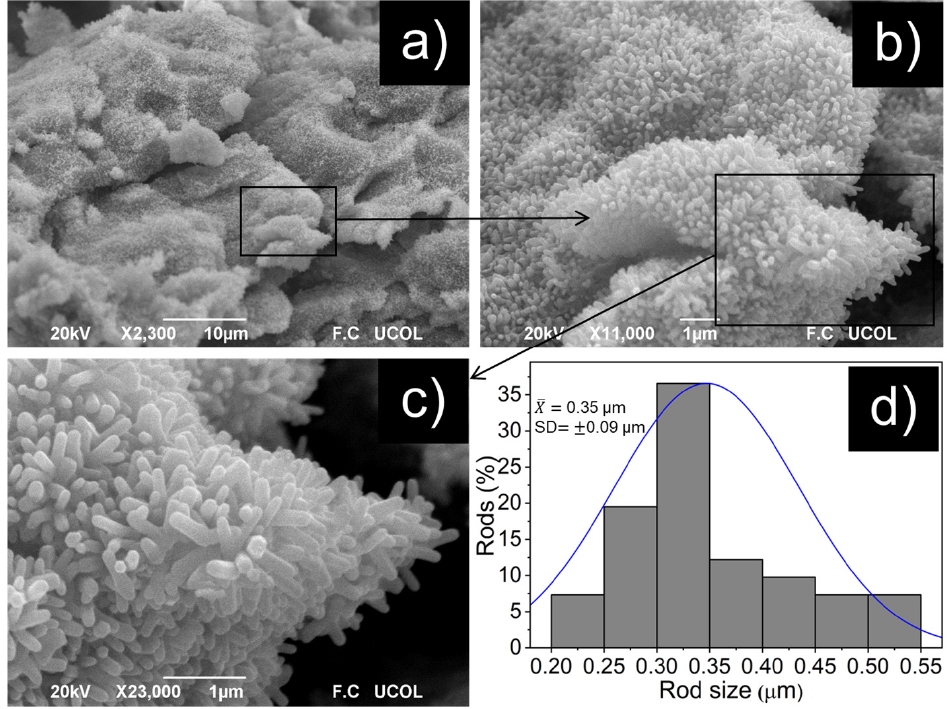
Figure 6. SEM micrographs of the ZnAl 2 O 4 synthesized at 700 °C at different magnifications: ( a ) 2300×, ( b ) 11,000×, and ( c ) 23,000×; the granule size distribution is shown in ( d ).